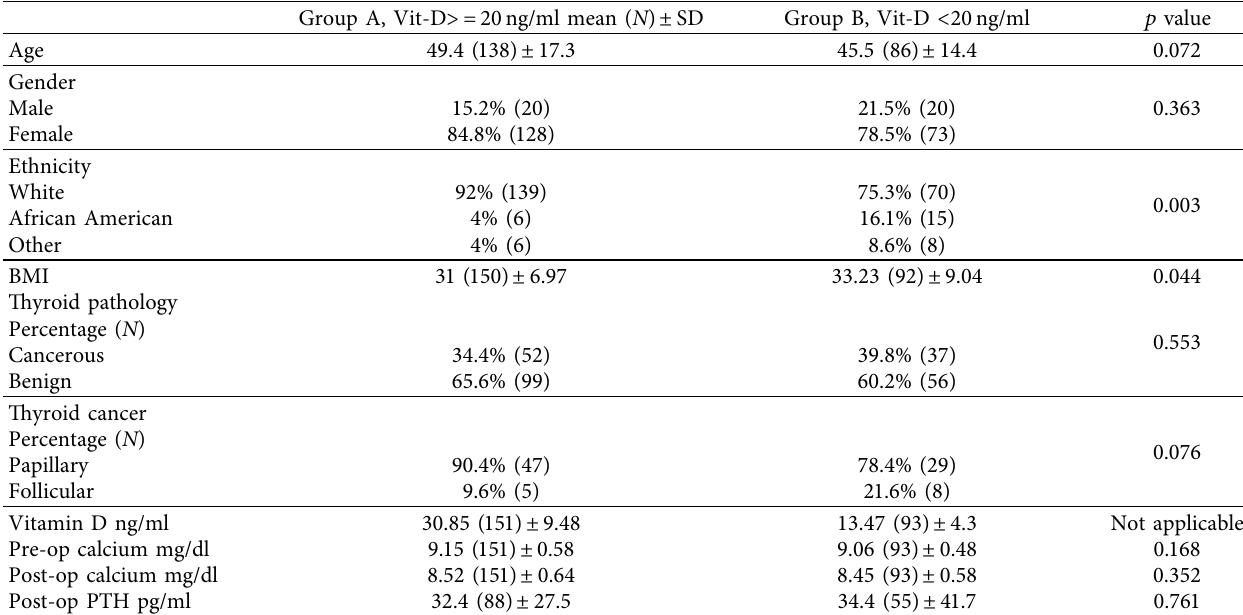
Table 1: Patient